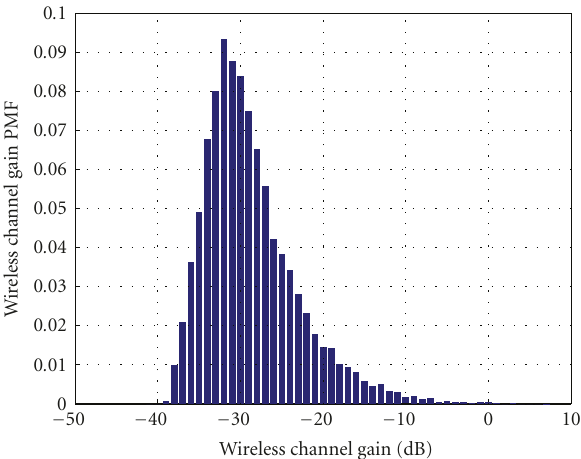
Figure 3: Wireless channel gain PMF derived by discretizing the wireless channel gain PDF.